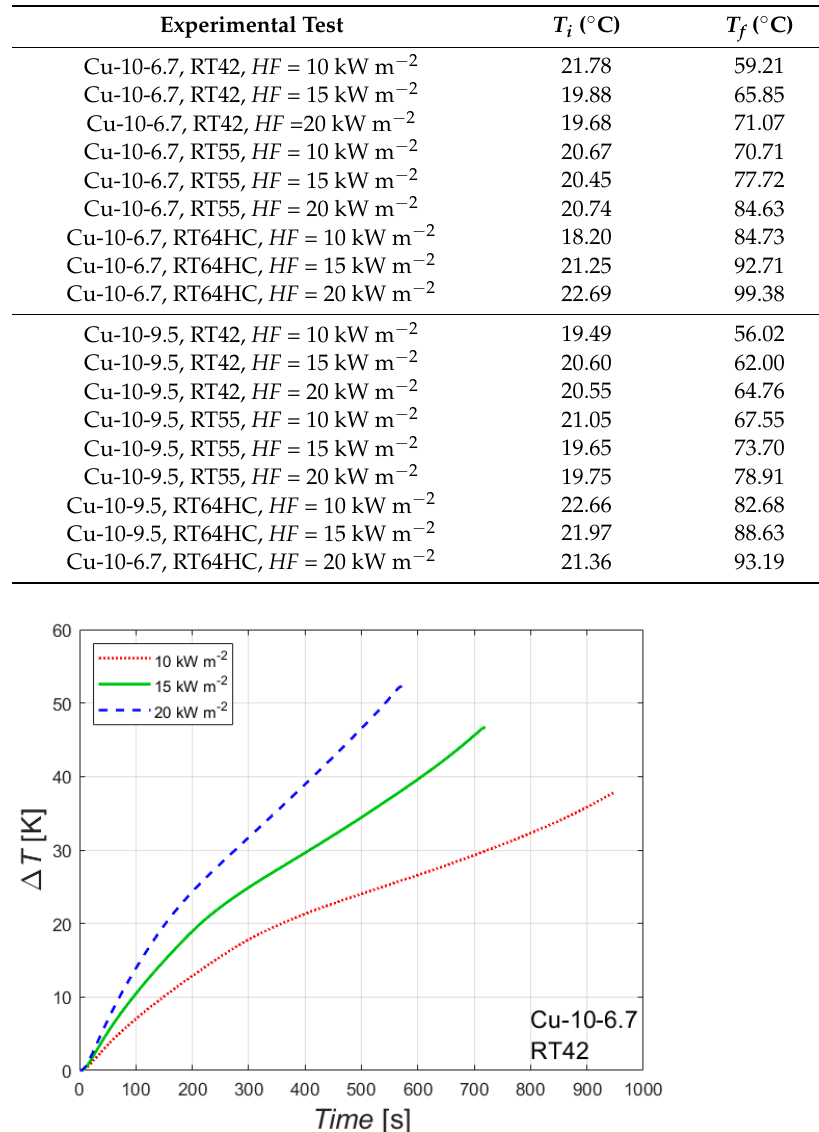
Figure 6. Effect of melting temperature on the difference between wall and initial temperatures for the 10 PPI copper foam with a porosity of 0.933 with an imposed heat flux of 10 kW m − 2 . The melting temperature affects both the time needed to completely melt the PCM and the temperature of the heated side at the end of the melting process. The lower the